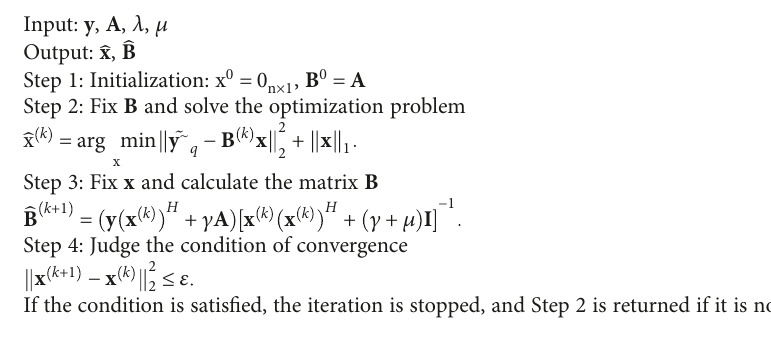
Algorithm 1: Algorithm Flow.